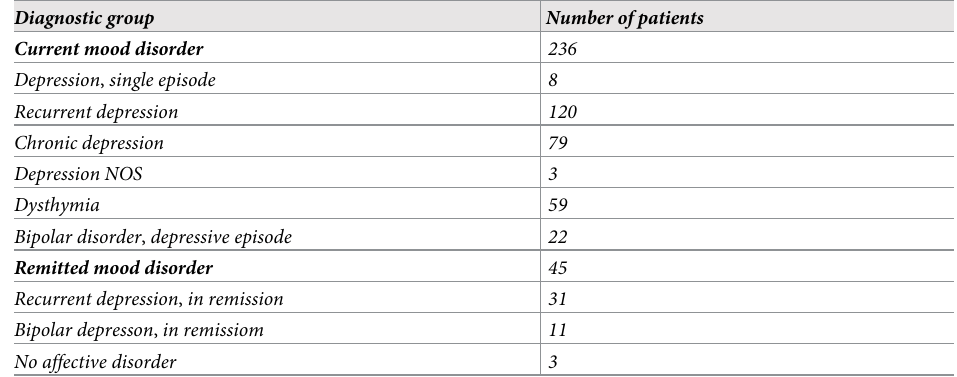
Table 2. Detailed diagnostic characteristics including type of affective disorder.